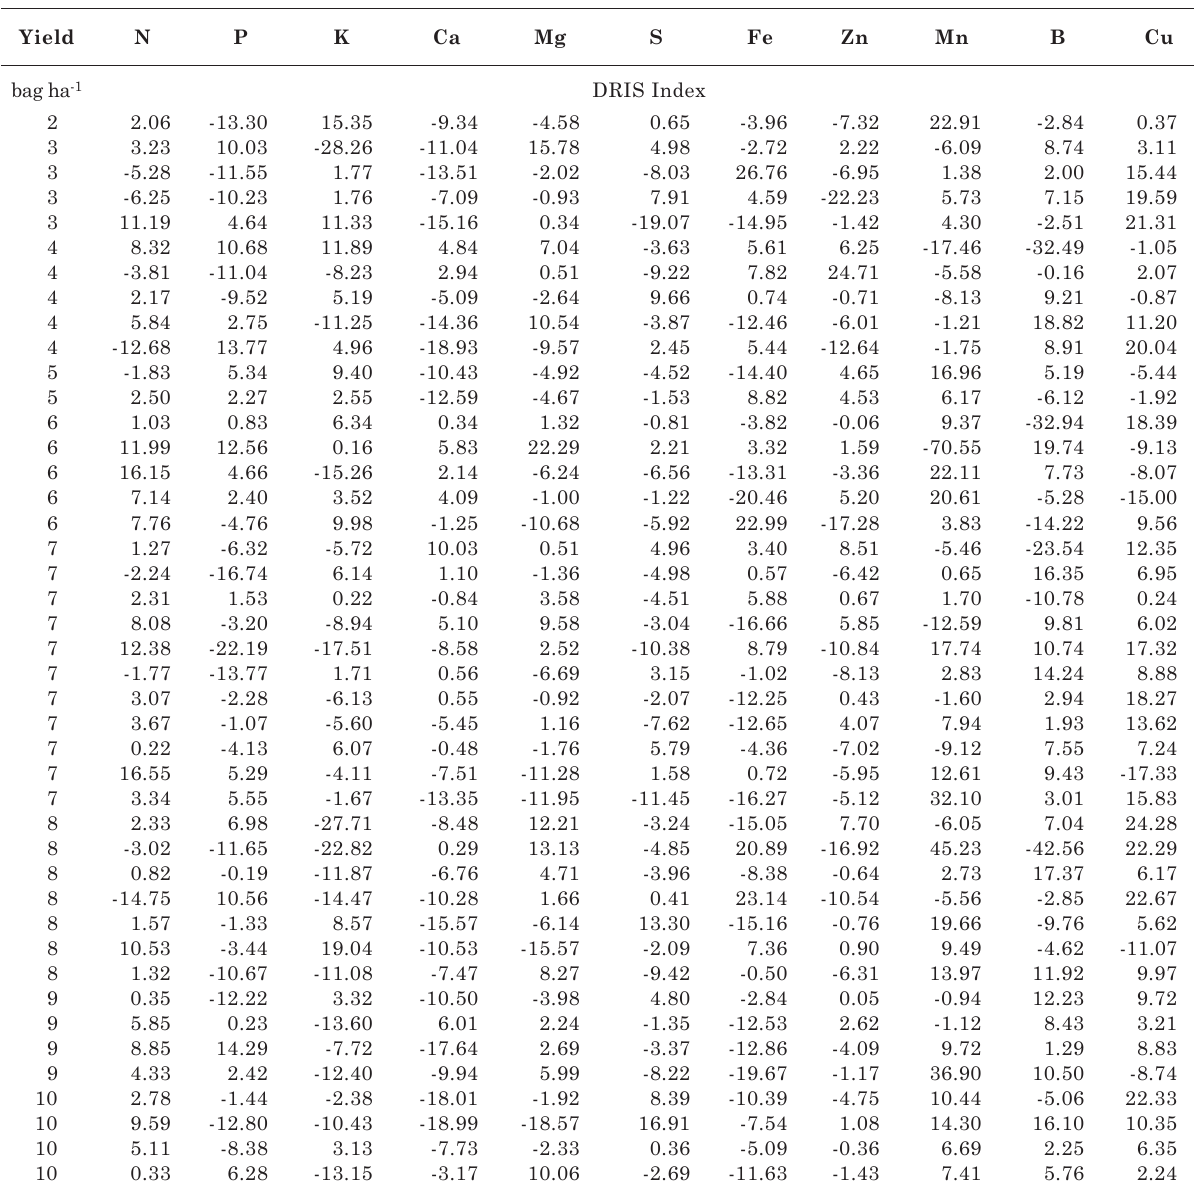
table 1. dris index for coffee yields up to 10 bags ha -1